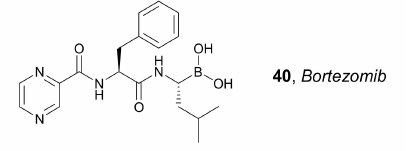
Figure 20. Chemical structure of Bortezomib 40